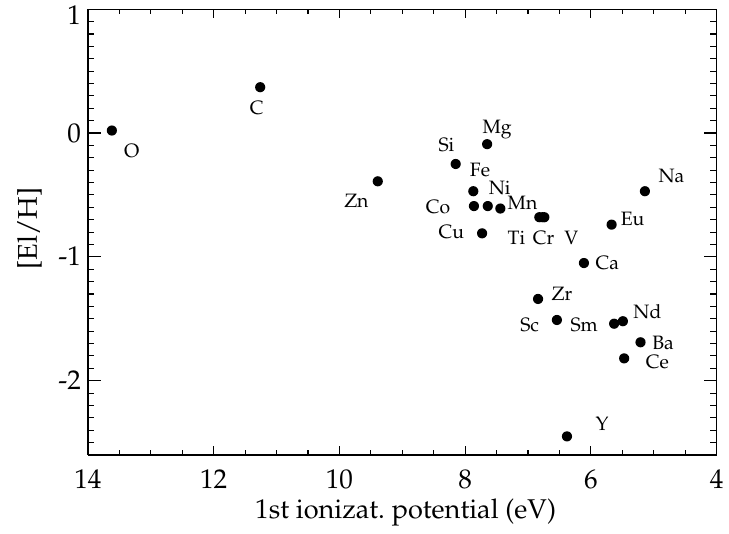
Fig. 4. Abundances [El/H] vs. the first ionization potential for R